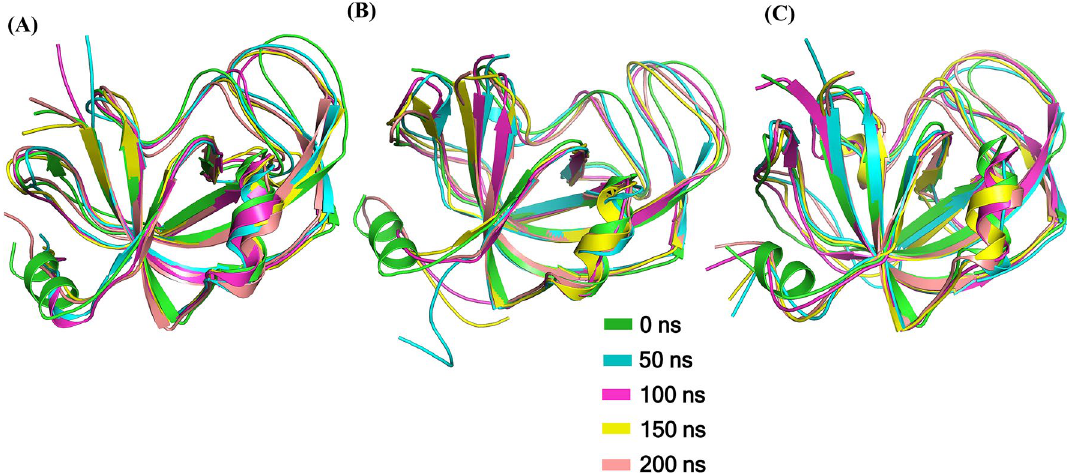
Figure 8. Structural snapshots of CTC1- ( A ) WT, ( B ) R806C, and ( C ) R806L at an interval of 50 ns from 0 to 200 ns of simulation. Structures were drawn using PyMOL (https:// pymol. org/2).